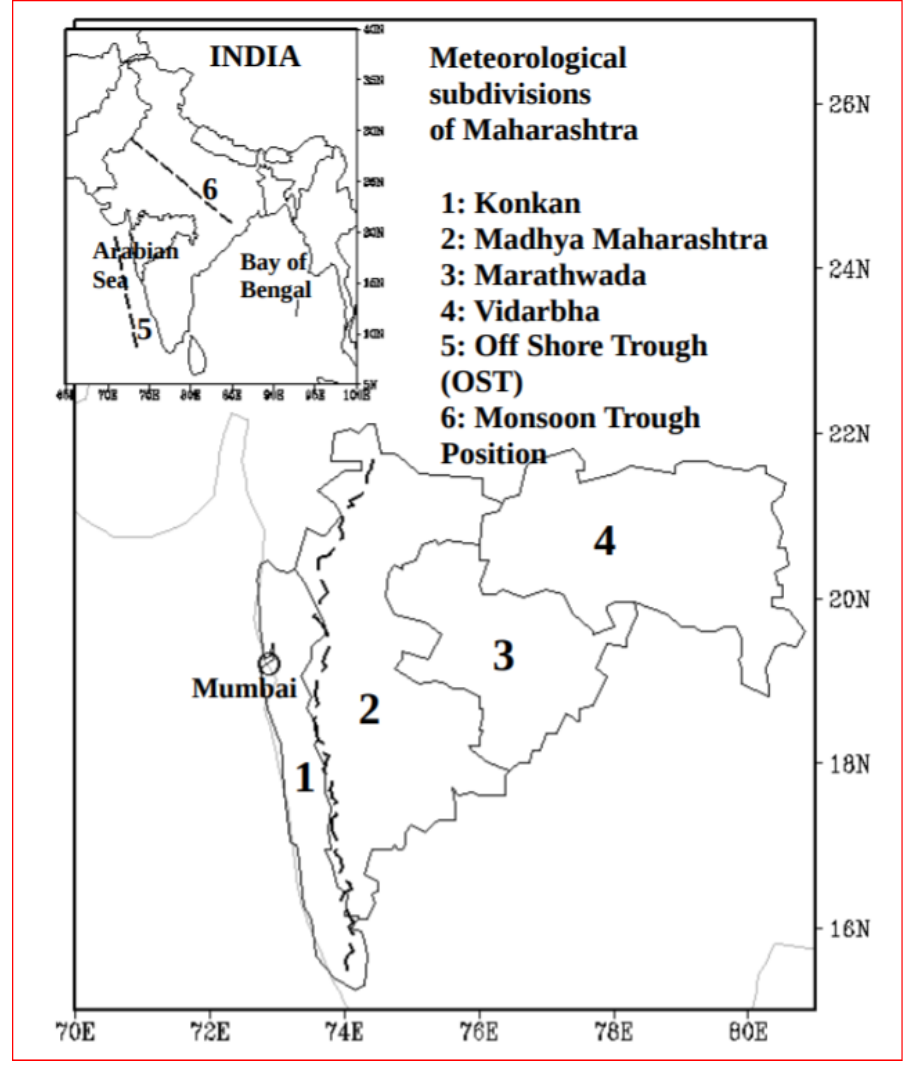
Figure 1. Map of India inset map of Maharashtra state in India. The dotted line in the north-south direction is the WG mountain line. The meteorological subdivisions in the state of Maharashtra are denoted by (1) Konkan on the west coast, (2) Madhya Maharashtra on the leeward side of the WG, (3) Marathwada, and (4) Vidarbha. The west coast offshore trough (WCT) and southerly location of the monsoon trough (MT) are indicated by numbers 5 and 6, respectively. The location of Mumbai on the west coast in the Konkan subdivision is shown by an open circle.